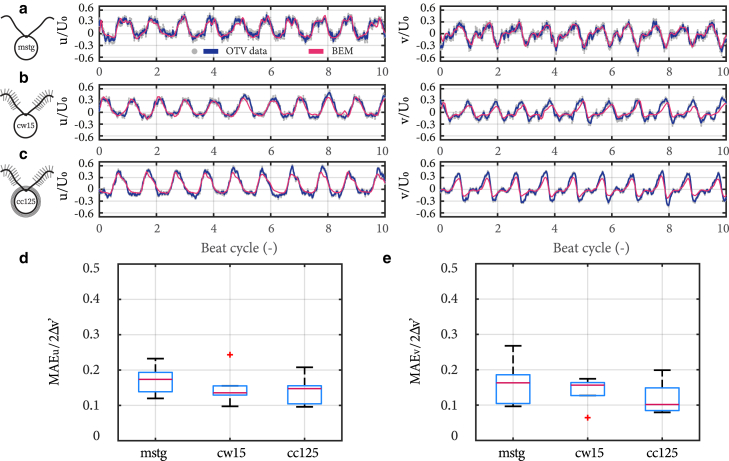
Near-field hydrodynamics of beating flagella. (a–c) Axial u (left) and lateral v (right) flow as a function of beat cycle for a typical (a) mstg, (b) cw15, and (c) cc125 cell. The red solid curve is the prediction from hydrodynamic modeling (BEM). (d and e) Comparison of MAE of BEM predictions for (d) axial flows MAEu and (e) lateral flows MAEv, for mstg, cw15, and cc125 strains from left to right, respectively. The data represented are from within ∼20 μm of a beating cell (y<0.2δ), or the lightly shaded areas in Fig. 5. The sample size for (d) and (e) is N=6 for each strain. To see this figure in color, go online.